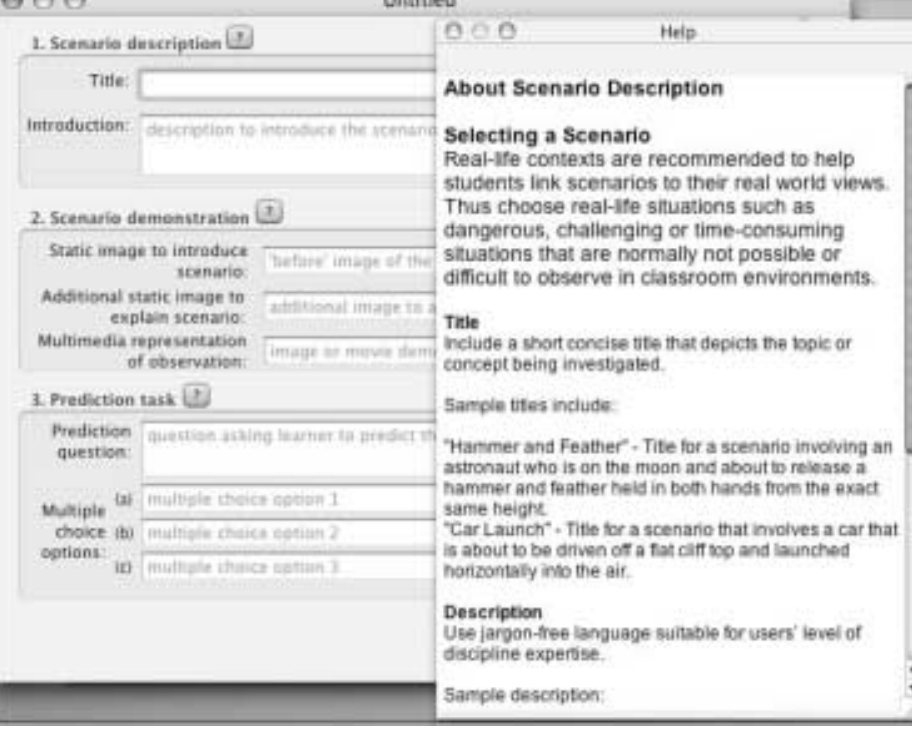
Figure 6. Example of pedagogical support provided by the UOS Editor when designing a POE